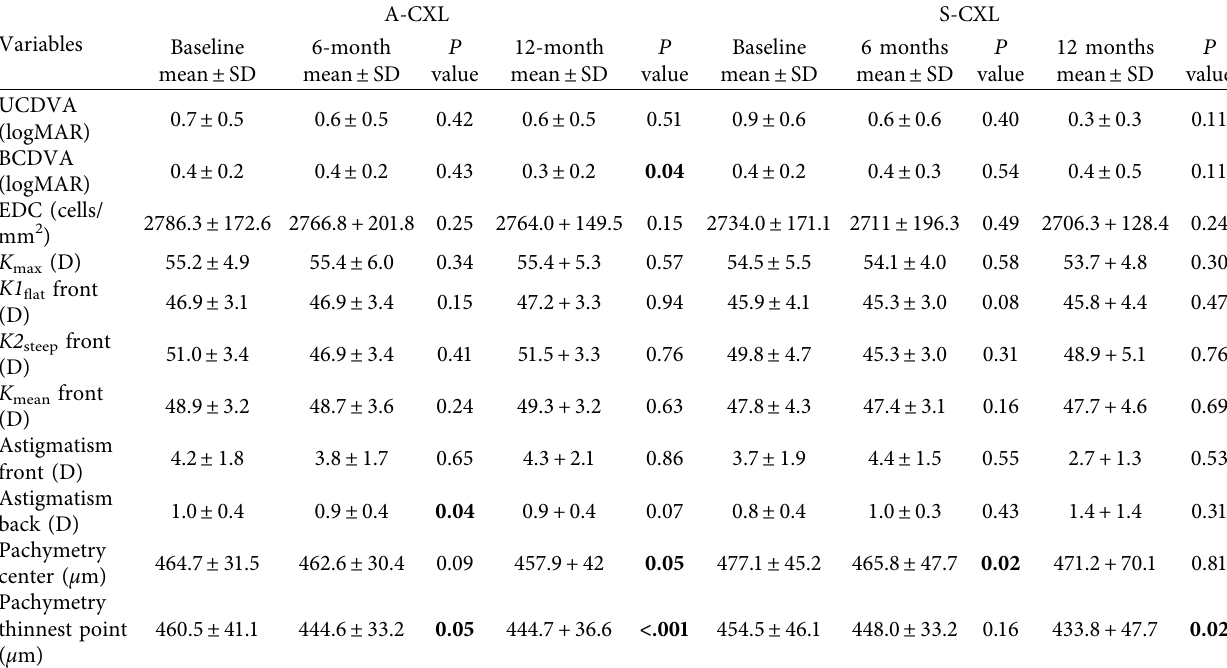
Table 3: Intragroup comparison of preoperative and 6-month and 12-month postoperative clinical